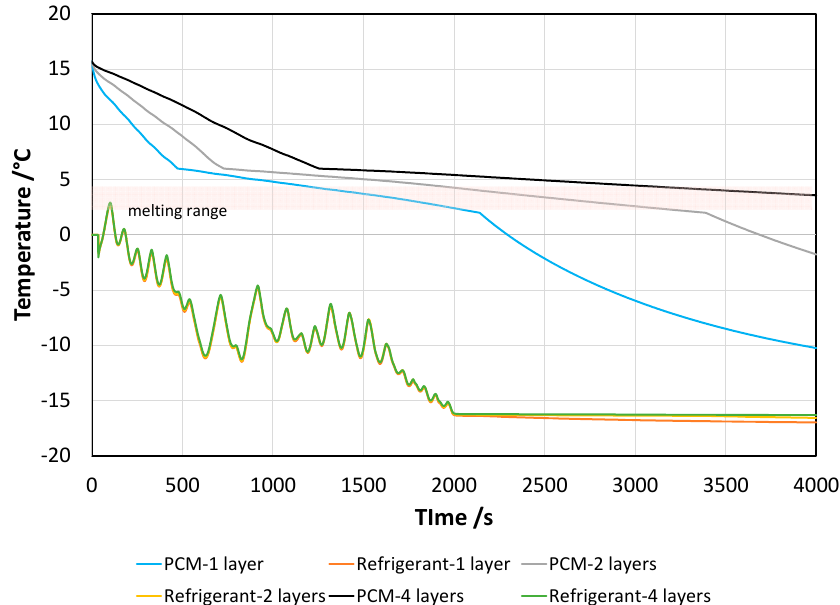
Figure 5. Temperatures in the PCM and refrigerant circuit during charging for different numbers of stacked PCM layers.